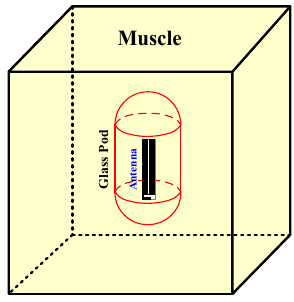
Figure 3. The MICS/ISM meander-line microstrip antenna encapsulated in a glass pod inside the pseudo-muscular cubicle.